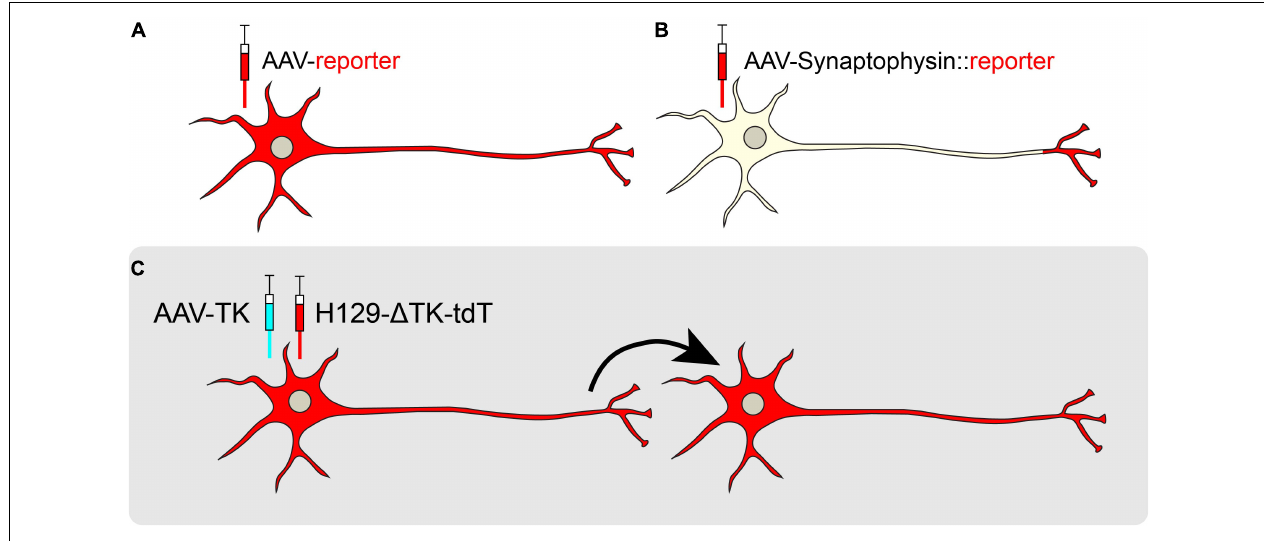
FIGURE 4 | Anterograde viral tracing strategies. (A) Non-transsynaptic anterograde tracing using expression of a cytosolic or membrane-bound fluorescent reporter. (B) Non-transsynaptic anterograde tracing using expression of Synaptophysin fused to a fluorescent reporter. (C) Transsynaptic, monosynaptic tracing using the H129- (cid:49) TK-tdT system. When TK is provided in trans , the H129 reporter virus may jump across one synapse in an anterograde manner.